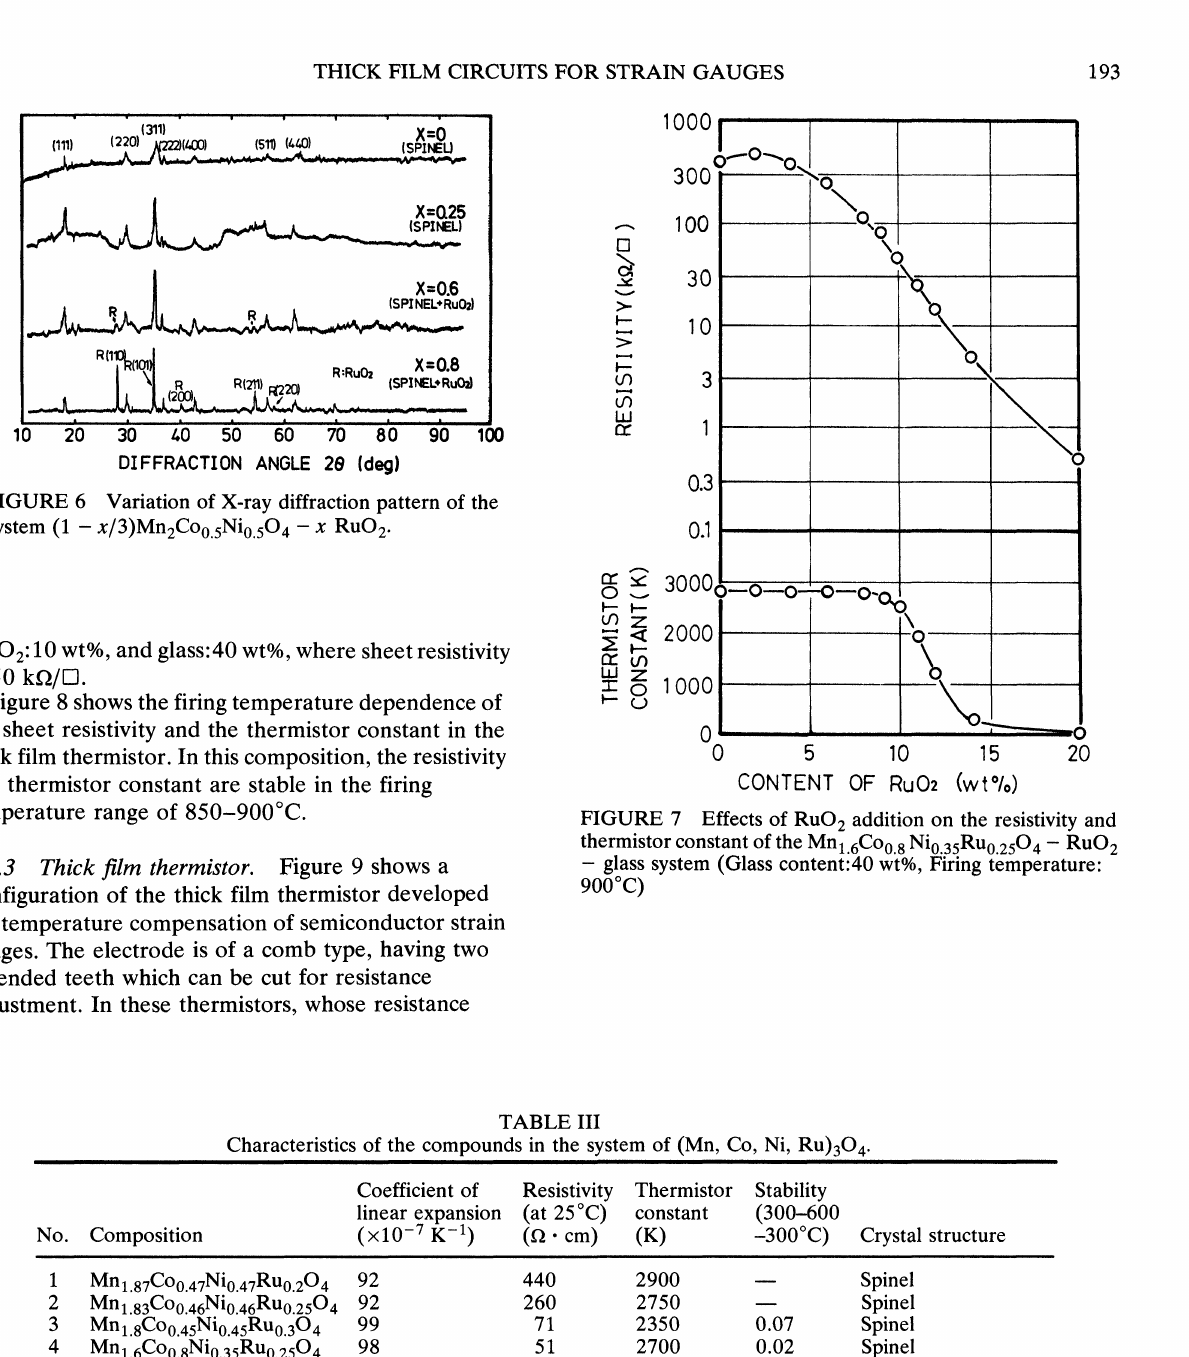
TABLE III Characteristics of the compounds in the system of (Mn, Co, Ni,